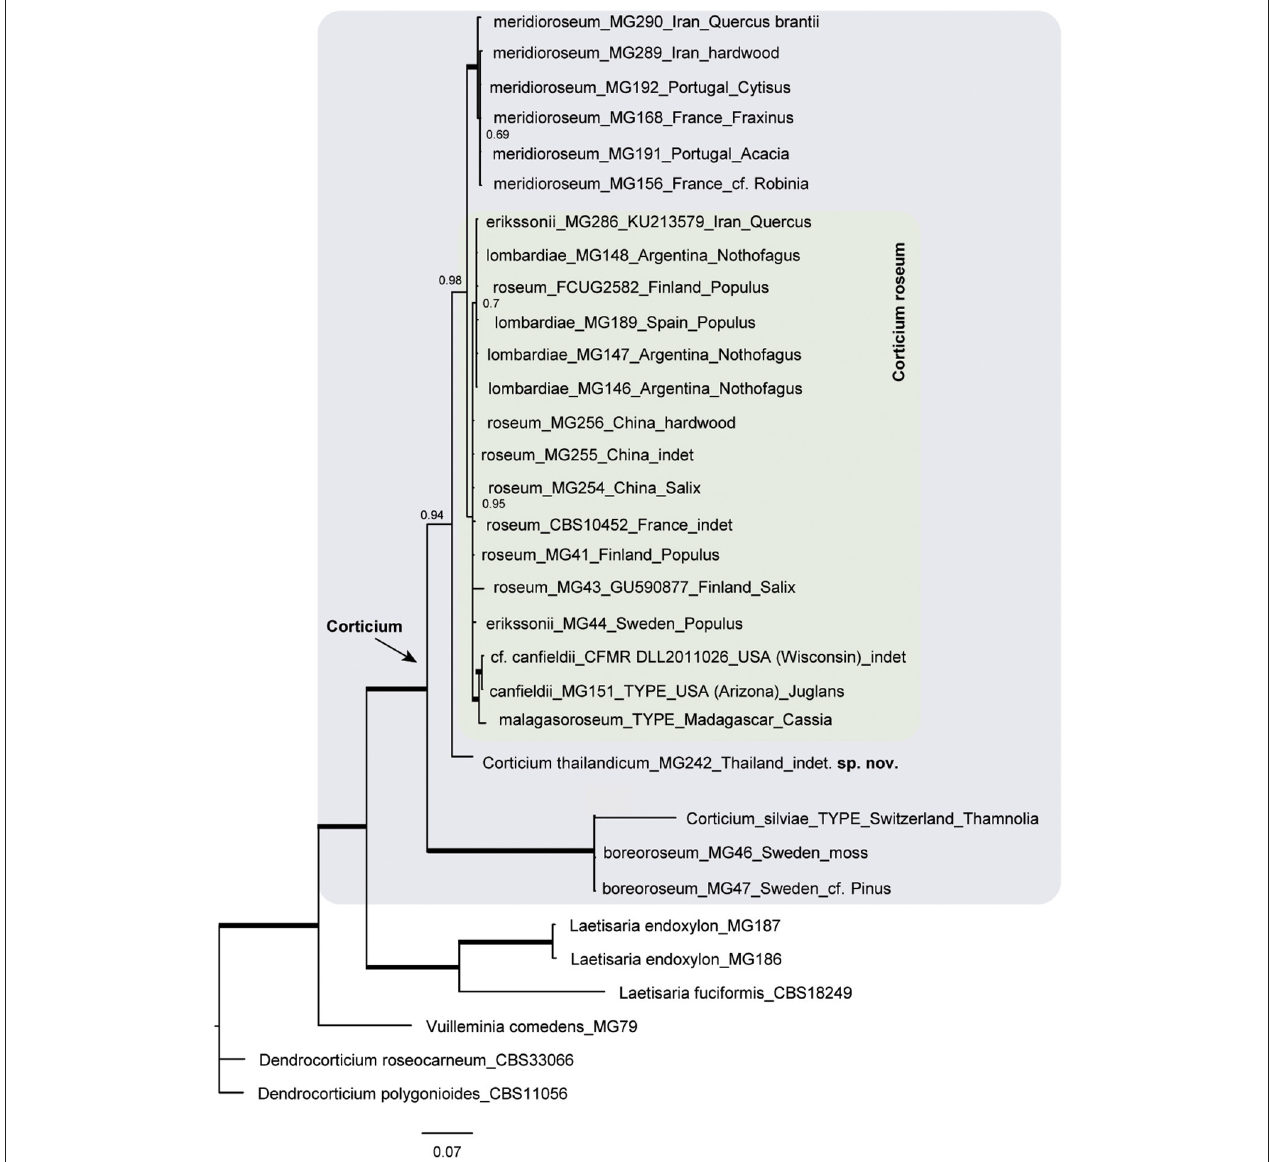
FIGURE 5 | Phylogram of the combined IGS-ITS dataset for the Corticium roseum group. The pink box marks the Corticium clade, and the inside green box marks C. roseum . Country of collection and substrates are shown on the branches. Branches in bold have the posterior probability = 1.00. The scale bar represents the expected changes per